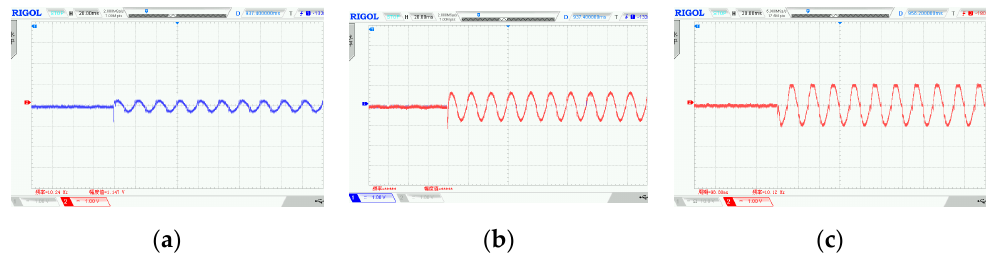
Figure 18. Experimental results of zero-sequence currents when a single-phase earth fault occurs on the middle of the third feeder: ( a ) First feeder; ( b ) second feeder; and ( c ) third feeder.